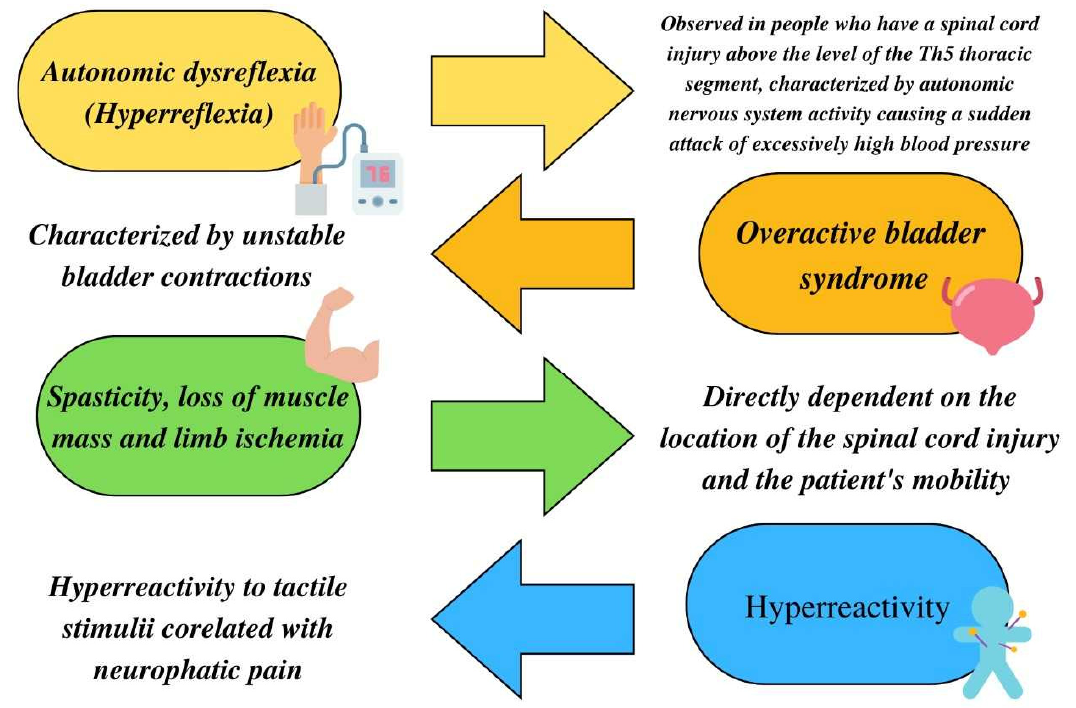
Figure 1. Types of disturbances in tetraplegia.